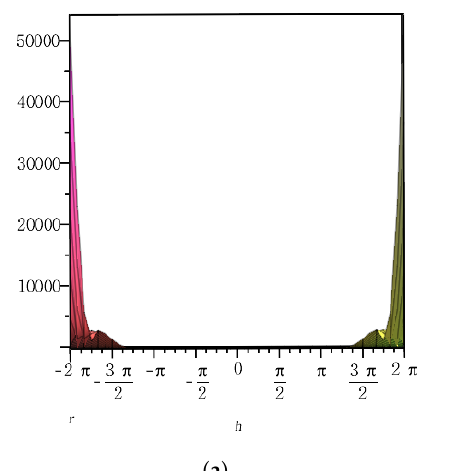
Figure 5. ( a ) Three-dimensional (3D) graph showing the relative error Err ( sin z , z 0 ) at z 0 according to h and r . ( b ) Contour line drawn on a plane to estimate the distribution and magnitude of the relative error Err ( sin z , z 0 ) according to h and r in the 3D graph of ( a ).